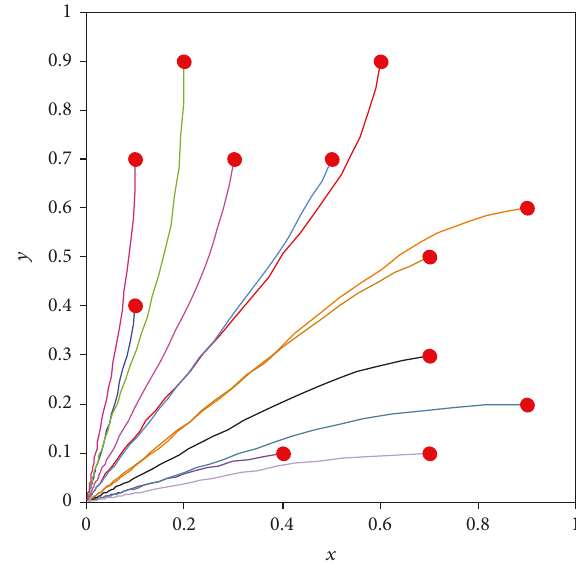
Figure 7: x and y during the learning process of EAQR in Case 1 ( ε = 0 ).